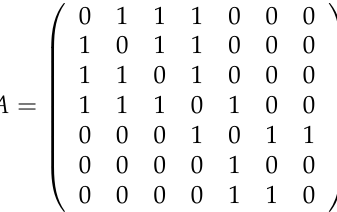
(cid:105) l i l j = 1 2 m 2 ∗